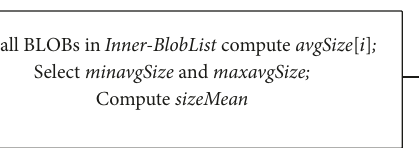
Figure 7: Step 4 : block diagram of algorithm for detecting three PDPs in QR code.